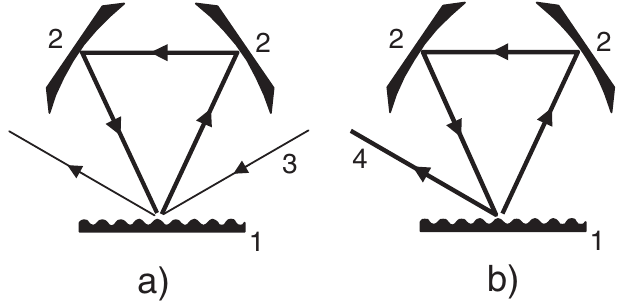
FIG. 2. Compression scheme based on the quasioptical reso- nator: 1—diffraction grating/switch; 2—focusing mirrors; 3— input pulse; 4—output pulse; (a)—resonator in the regime of energy storage; (b)—resonator in the regime of output of the compressed pulse.